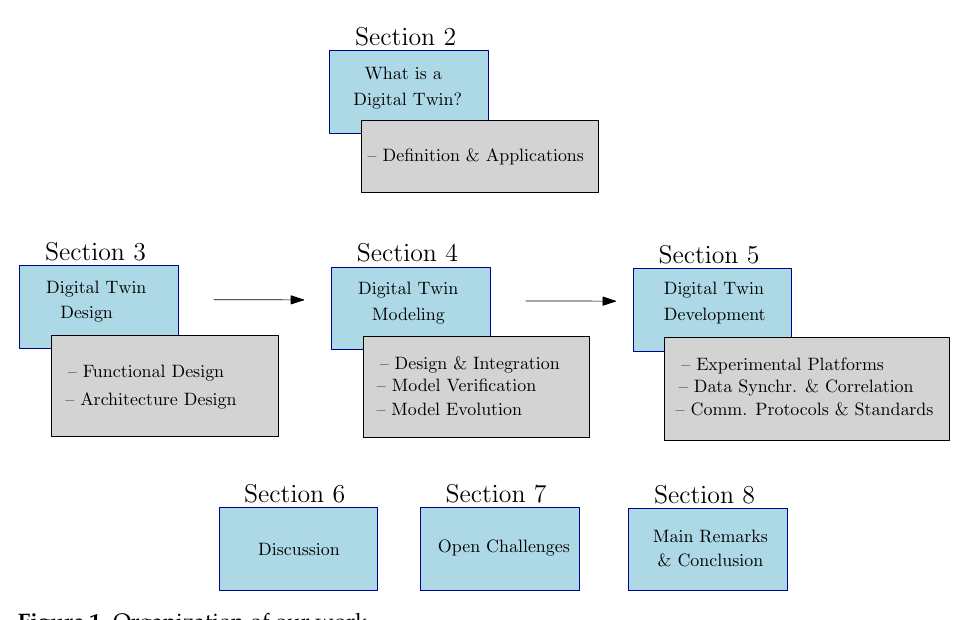
Figure 1. Organization of our